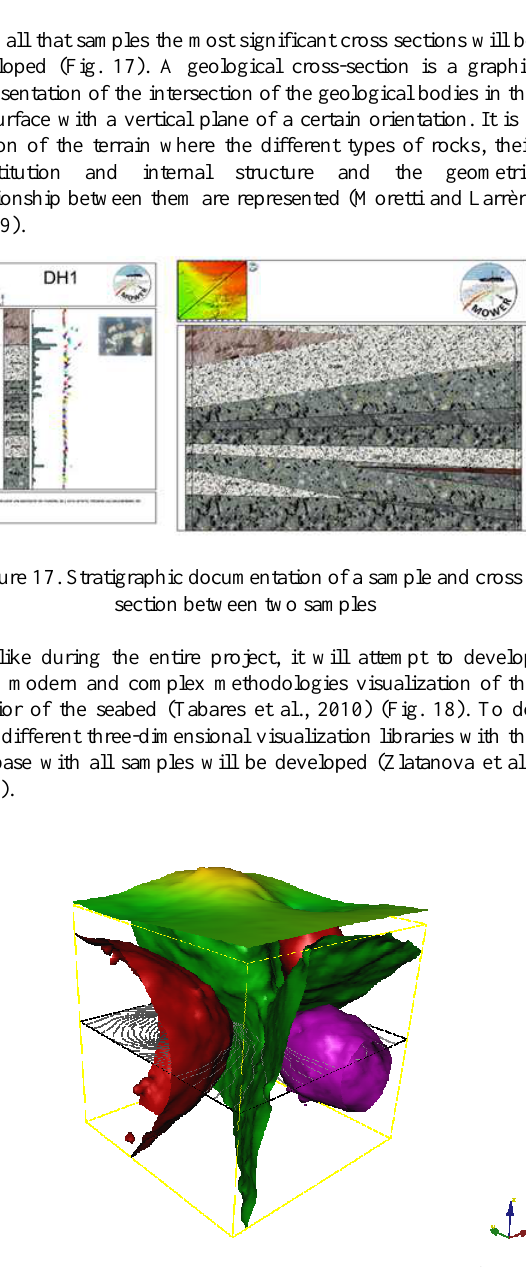
Figure 18. Three-dimensional visualization prototype of the subsoil of a grid of